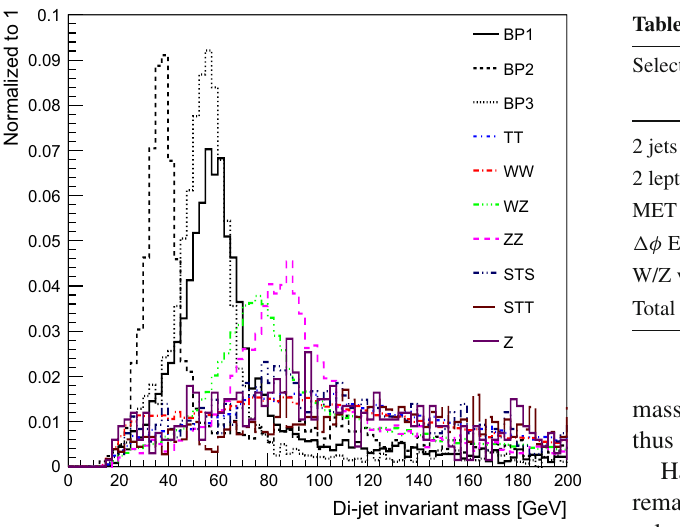
Fig. 6 The distribution of di-jet invariant mass in signal and back- ground events